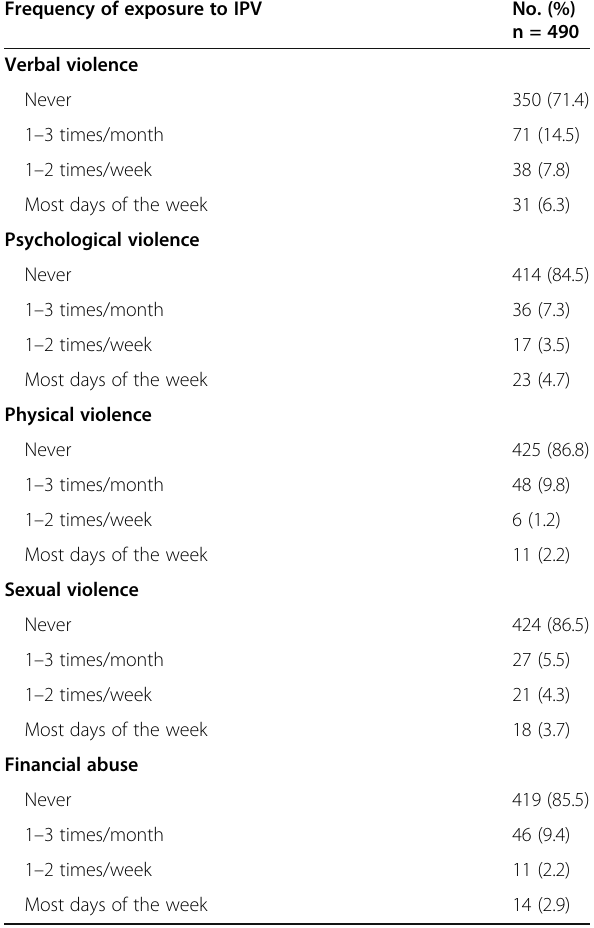
Table 2 Distribution of adult Arab women according to the frequency of exposure to different types of IPV during the COVID-19